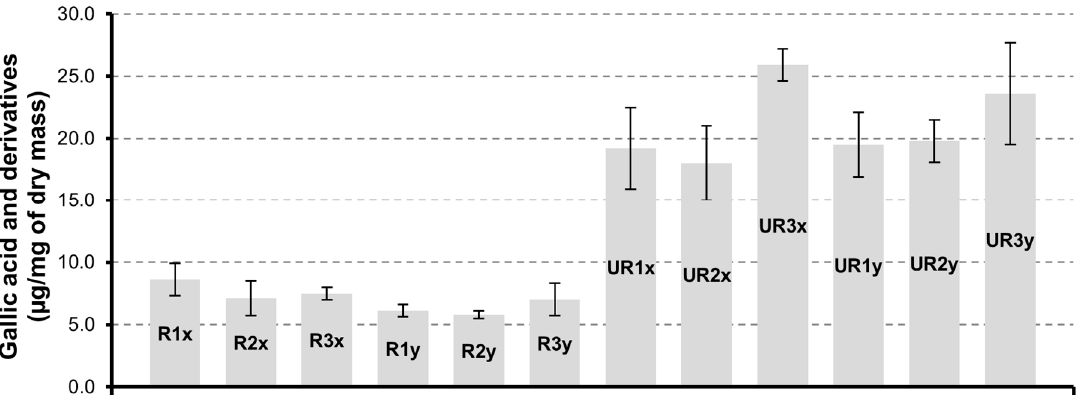
Figure 4. Gallic acid and derivatives quantification in CAR-R and CAR-UR extracts; 1 (24 h), 2 (48 h) and 3 (72 h) time of drying; x (3 h) and y (6 h) time of extraction.